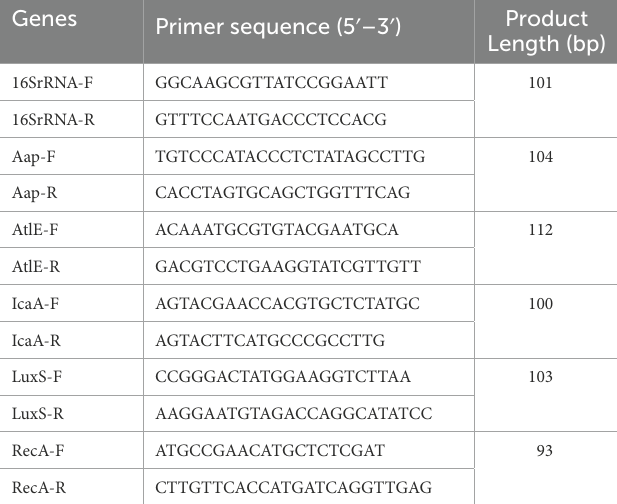
TABLE 1 Primer sequences of target